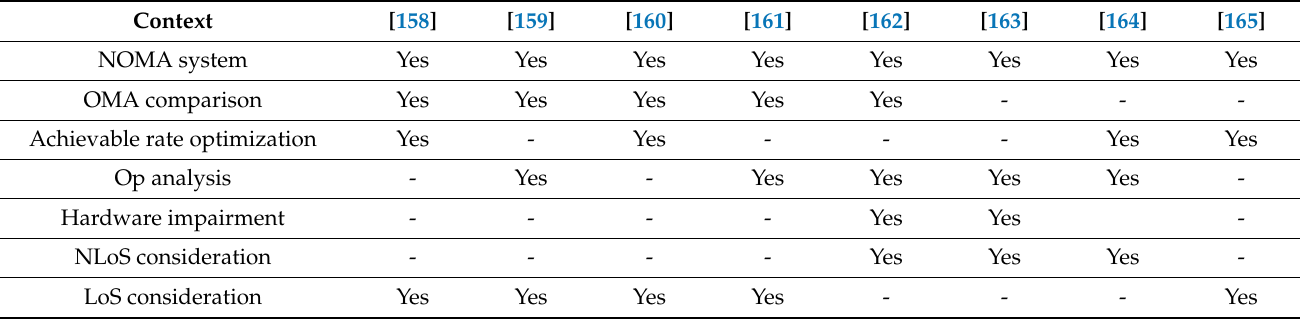
Table 5. Comparison of studies on IRS-assisted NOMA